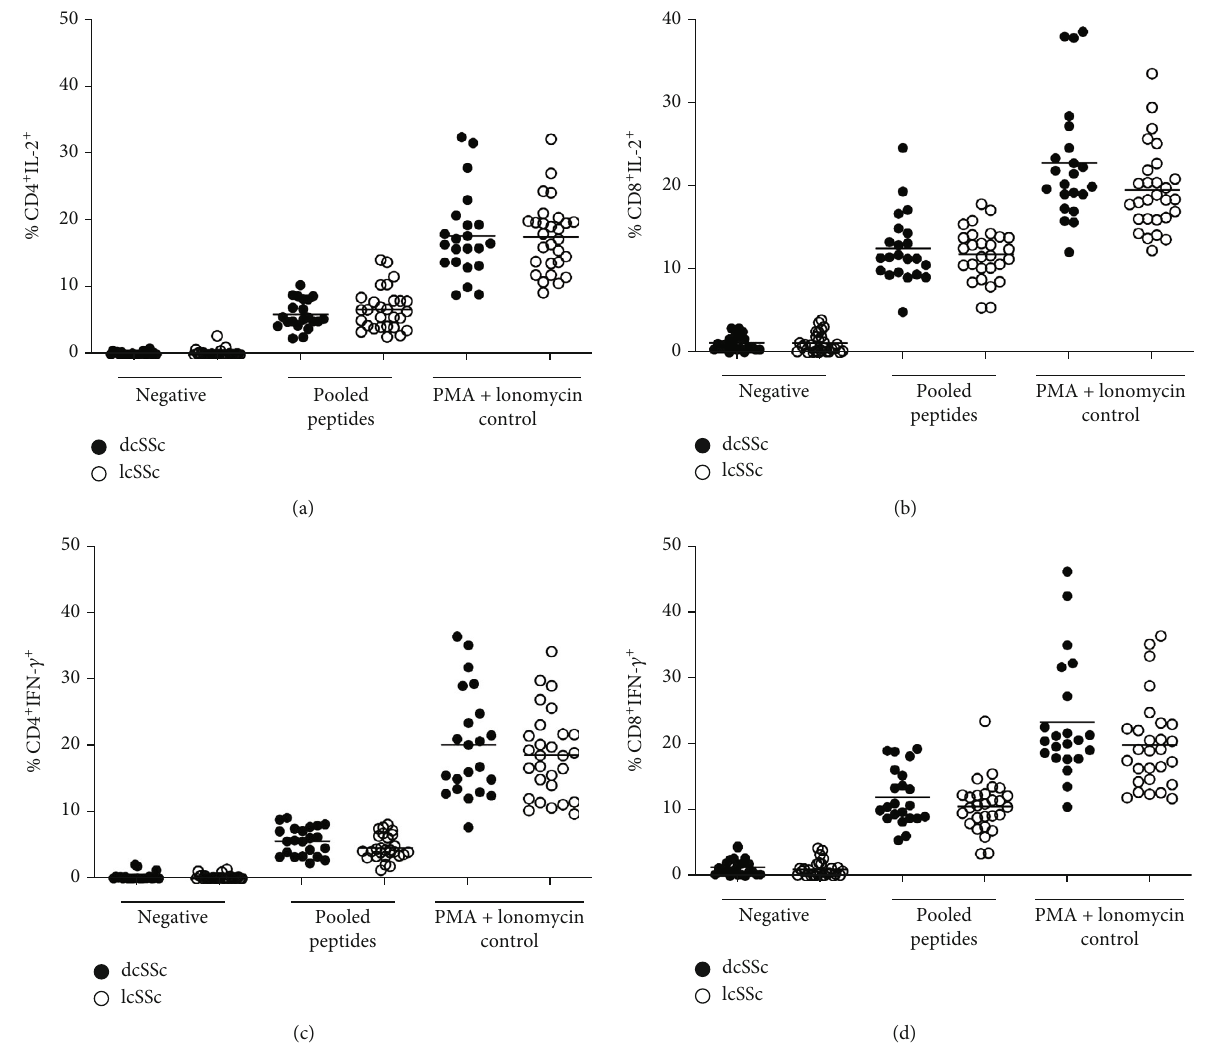
Figure 4: Percentage of cytokines (IFN- γ and IL-2) producing CD4 + (a, c) and CD8 + (b, d) T cells following stimulation with media (negative control), pooled peptides derived from DNA topoisomerase-I protein, and PMA ionomycin (positive control) in dcSSc ( n = 22 ) and lcSSc ( n = 28 )